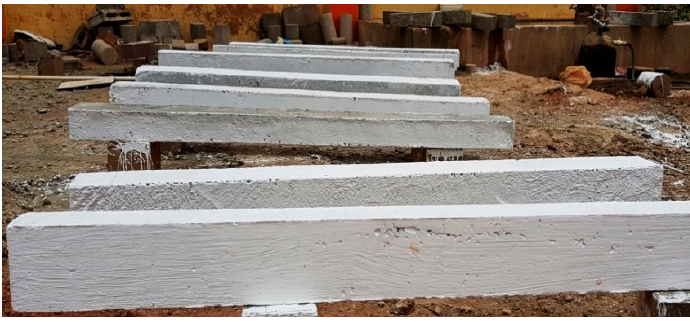
Figure 5. The RC beams cast for flexural testing.